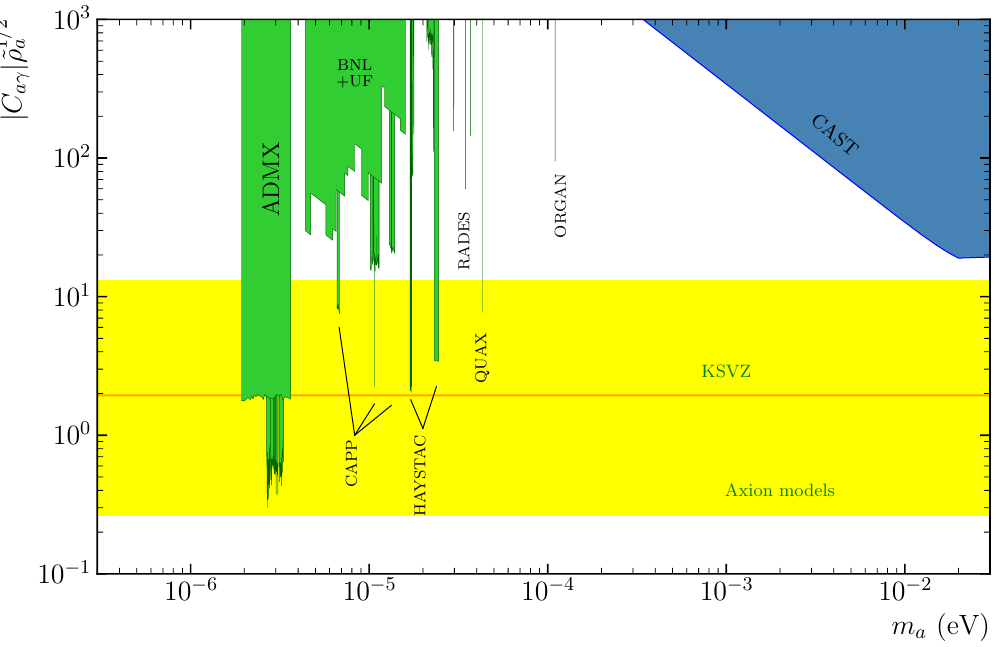
Figure 6: Zoom-in of the region of parameters where most axion dark matter experiments are active (in green). The y -axis shows the adimensional coupling ∝ g / m C (scaled with the local axion DM density relative to the total DM a γ a γ a = ρ /ρ density, ˜ ρ , to stress that these experiments produce bounds that are a a DM dependent on the assumed fraction of DM in the form of axions). Thus the yellow region, where the conventional QCD axion models are, appears now as a horizontal band, but is the same yellow band shown in the other plots of this